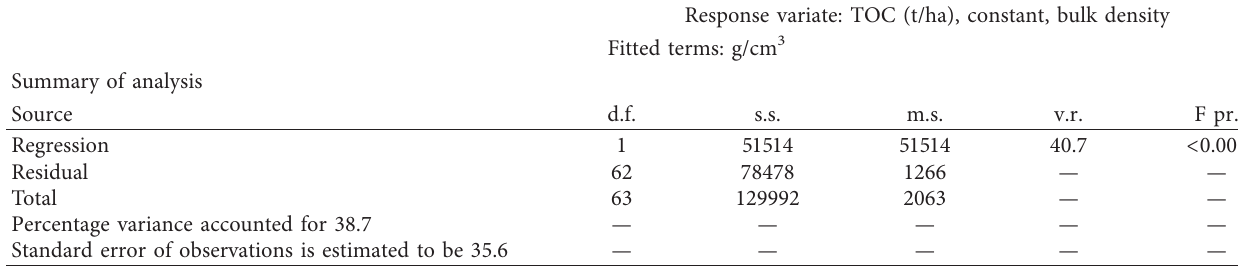
Figure 7: Relationship between carbon stocks and bulk density of soils. Table 2: Summary of regression analysis.